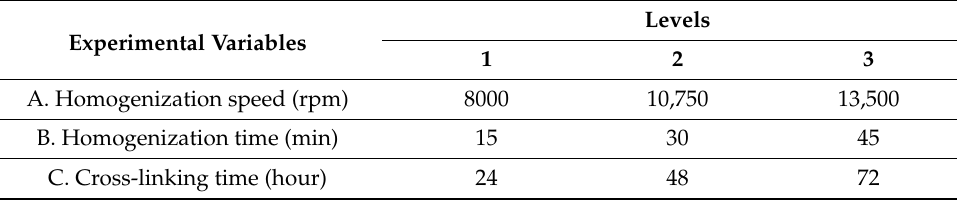
Table 1. Experimental variables and test levels under